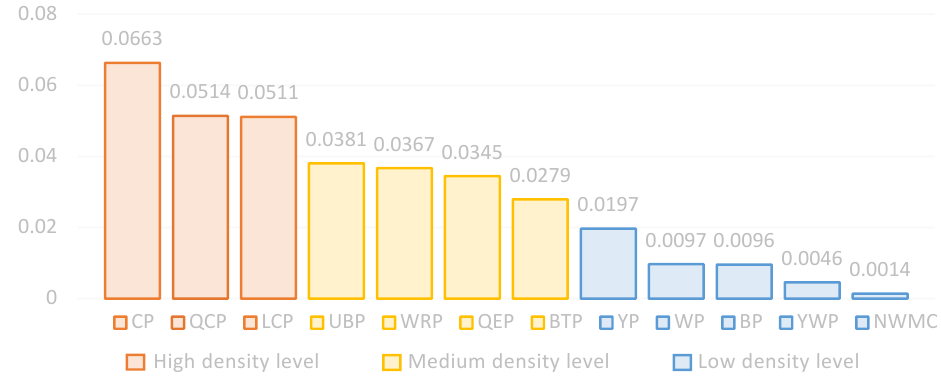
Figure 6. Park kernel density estimation mean data (persons/m 2 ).